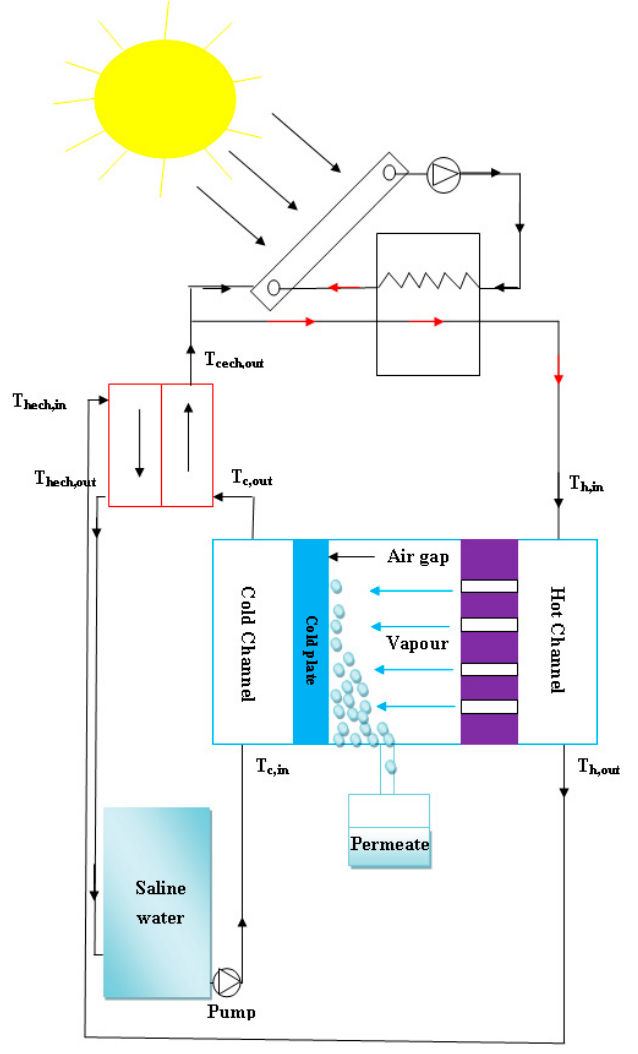
Figure 1. Schematic diagram of the AGMD process.